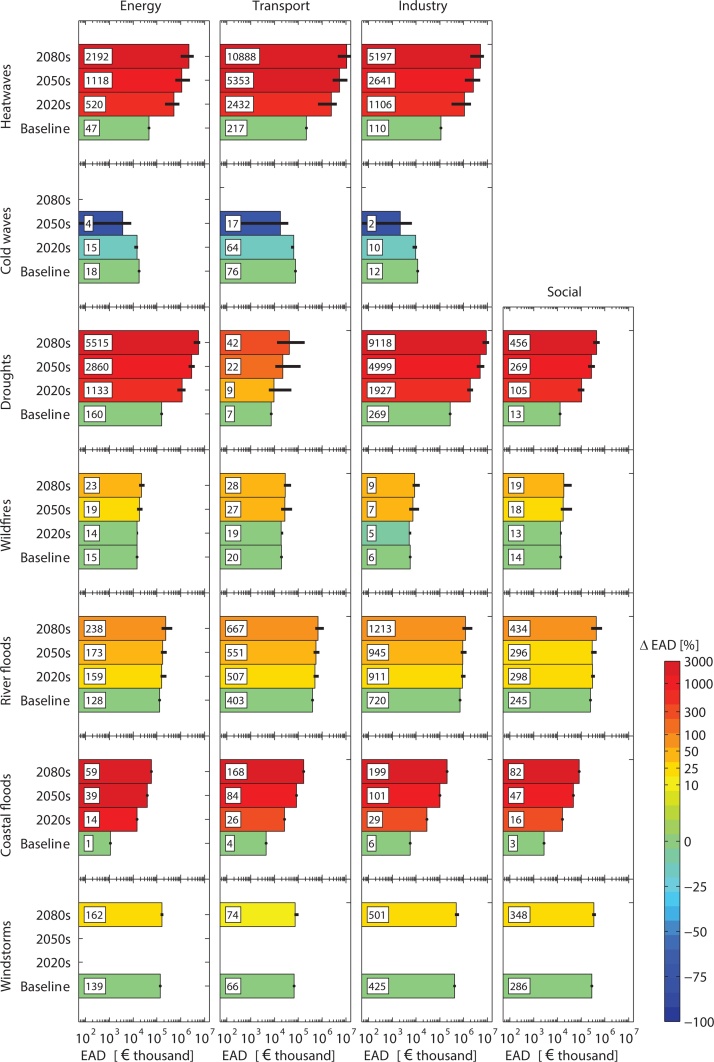
Expected annual damage (EAD) to critical infrastructures aggregated at European level (EU+) for each hazard, time period, and sector. Bar length indicates the ensemble median − also reported in numerical labels in millions. Whiskers reflect the inter-model climate variability (EAD for coastal floods has been produced for one climate configuration; Forzieri et al., 2016). Colors reflect the relative change in EAD with respect to the baseline.